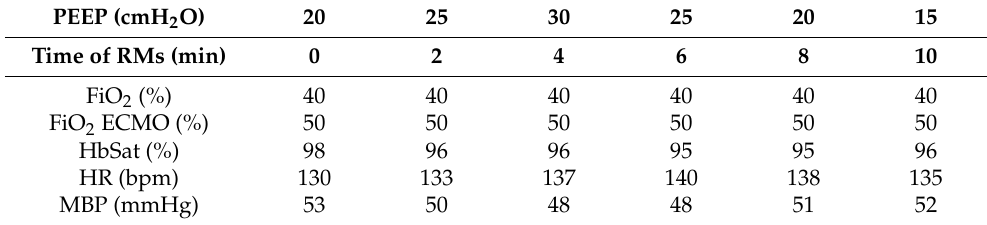
Table 1. Respiratory and hemodynamic status monitoring during RMs. PEEP: positive end-expiratory pressure; RMs: recruitment maneuvers; FiO 2 : fraction of inspired oxygen; ECMO: extracorporeal membrane oxygenation; HbSat: hemoglobin oxygen; HR: heart rate; MBP: mean blood pressure. PEEP (cmH 2 O)